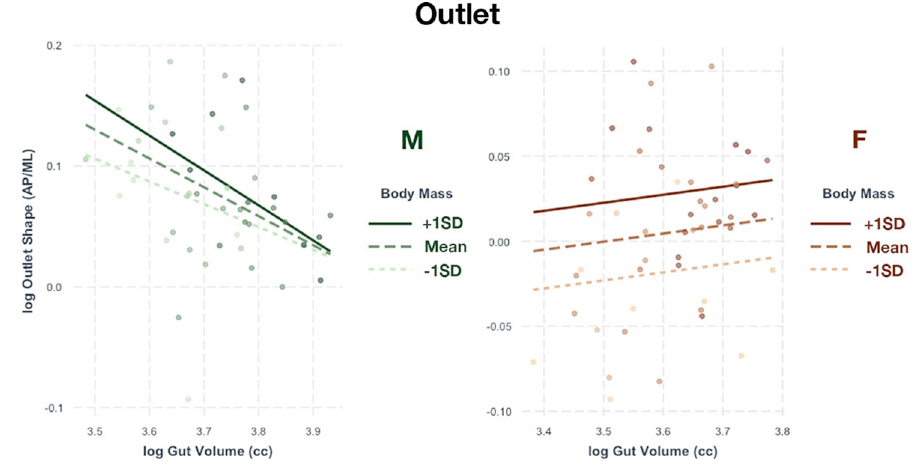
Fig 6. Relationship of outlet shape with gut volume. Regressions between gut volume and pelvic canal shape at the outlet relative to body mass. Only the female sample (right, orange) shows a significant relationship.